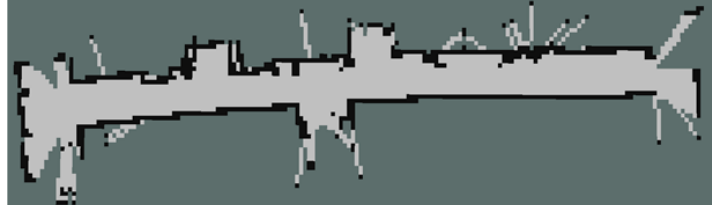
Figure 10. An example occupancy grid output visualisation.